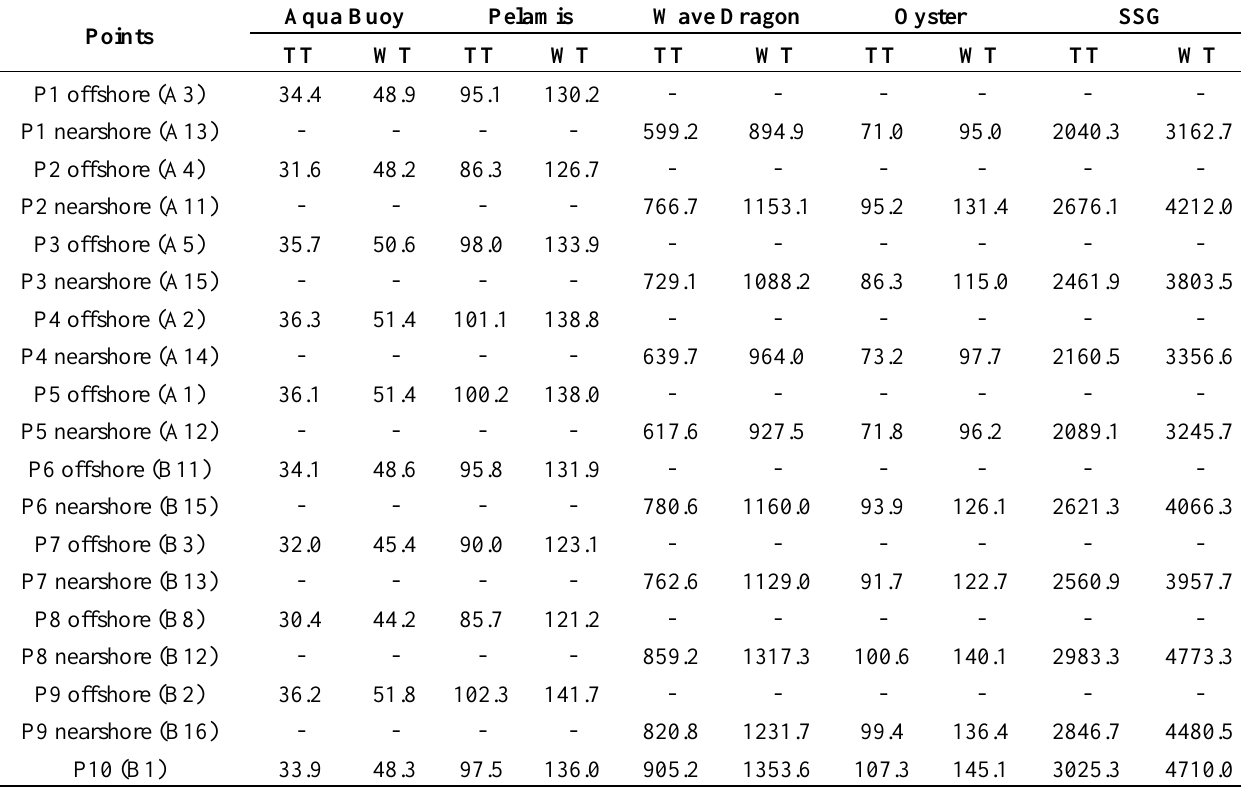
Table 5. Average electric power in kW for ten reference points from north to south along the Portuguese nearshore, estimations corresponding to the characteristics of five different WEC